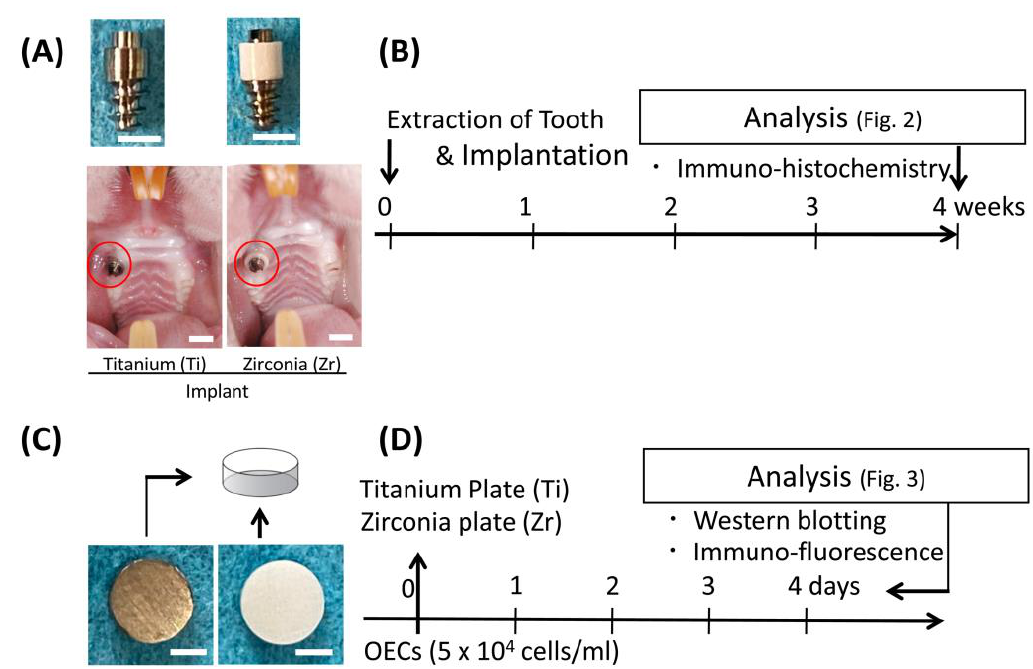
Figure 1. Implants and plates used in the present study and experimental design. ( A ) Photographs of implants with titanium or zirconia transgingival insert (upper panels), and intraoral view of rat after implant placement (lower panels); bar = 2 mm. ( B ) Experiment protocol for in vivo study. Implantation performed immediately after tooth extraction. ( C ) Photographs of titanium and zirconia plates; bar = 5 mm. ( D ) Experiment protocol of in vitro study.